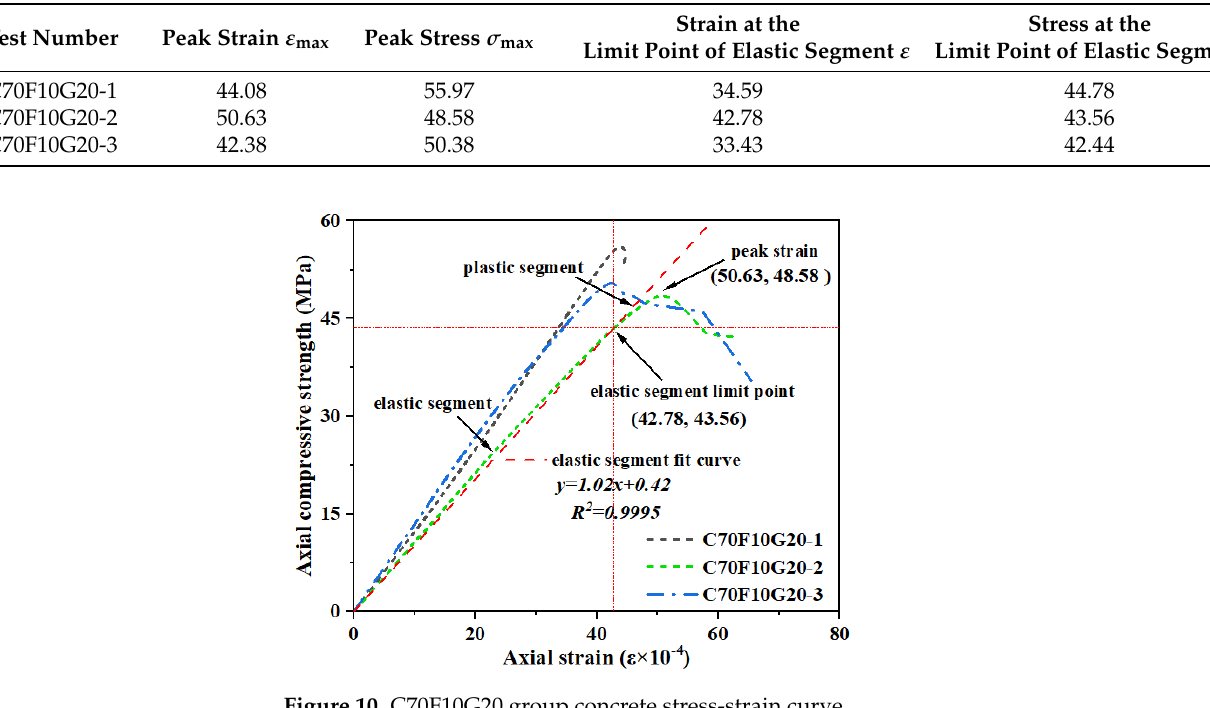
Figure 10. C70F10G20 group concrete stress-strain